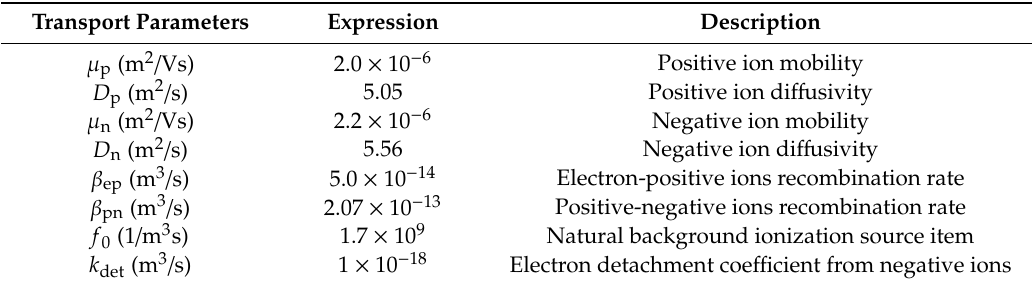
Table 1. Input parameters for the model.